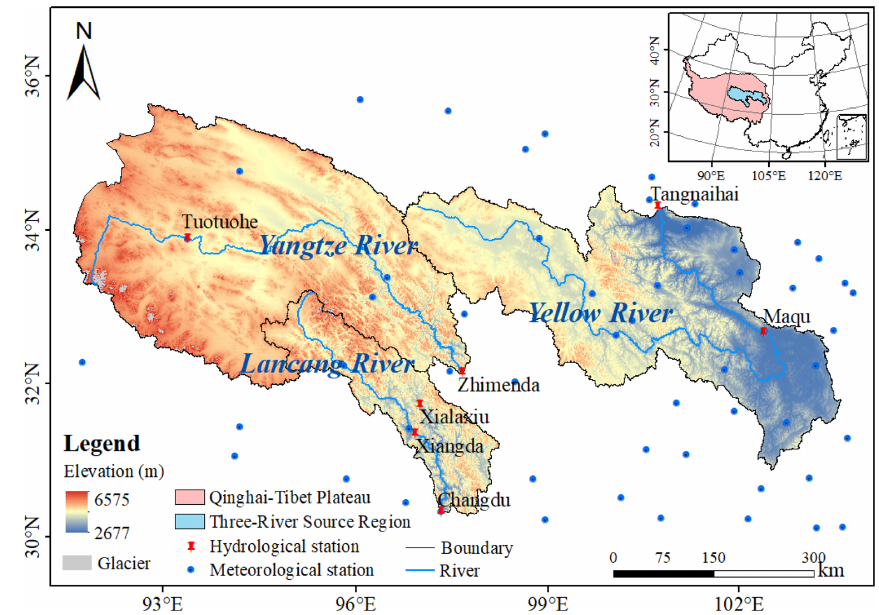
Figure 1. Topography of the Three-River Source Region; distribution of glaciers; and the locations of meteorological and hydrological stations, basin boundaries, and river courses of the Yellow, Yangtze, and Lancang. Table 1. Characteristics of seven sub-basins in the Three-River Source Region. Basin Hydrological Location Drainage Runoff data Glacier area station area (km 2 ) availability proportion (%) Latitude ( ◦ N) Longitude ( ◦ E) Yellow Tangnaihai 35.50 100.15 121972 1983–2018 Maqu